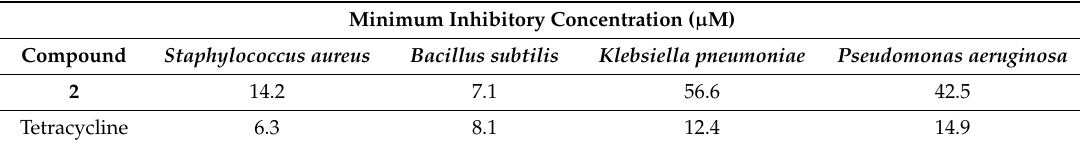
Table 5. MIC value of compound 2 with respect to the standard (Antibacterial evaluation).